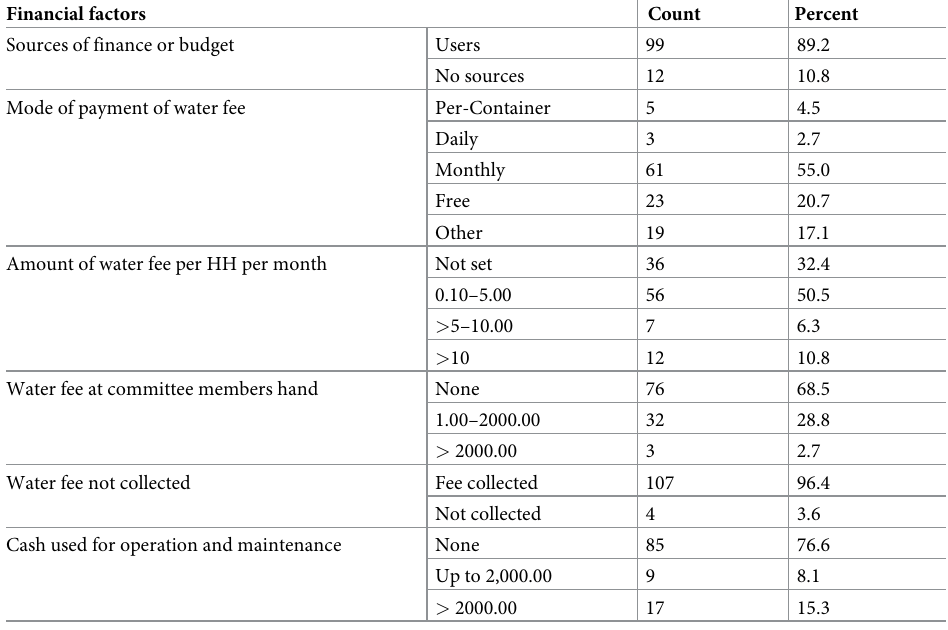
Table 10. Results of financial sources and its management in Amhara and Afar regions of